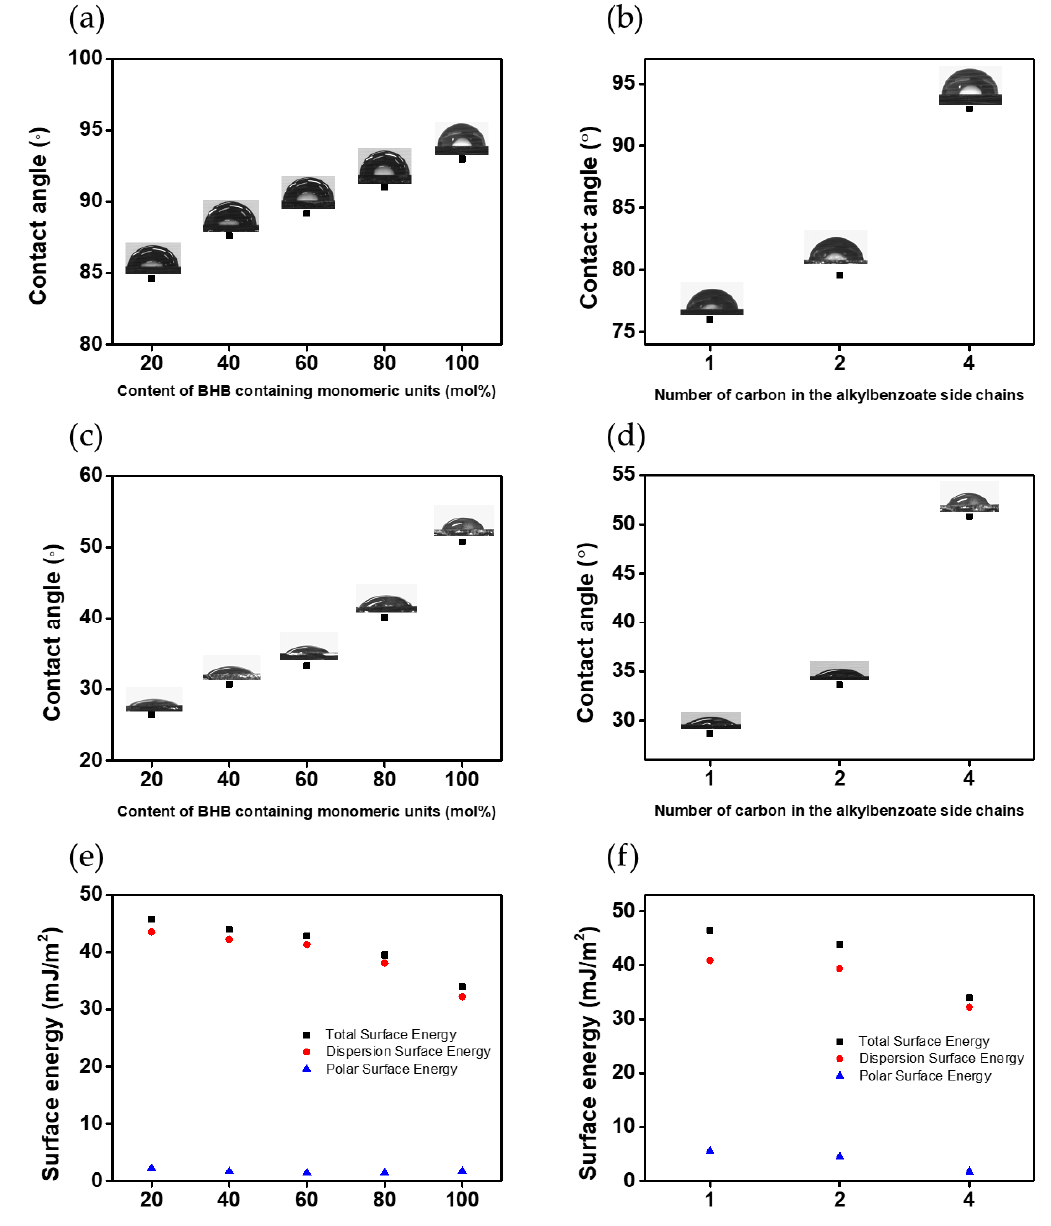
Figure 6. ( a ) Water, ( c ) diiodomethane contact angle, and ( e ) surface energy of polymer films according to the molar content of the butyl hydroxybenzoate moiety in the side groups and ( b ) water, ( d ) diiodomethane contact angle, and ( f ) surface energy of polymer films according to the number of carbons in the alkyl benzoate side chains.